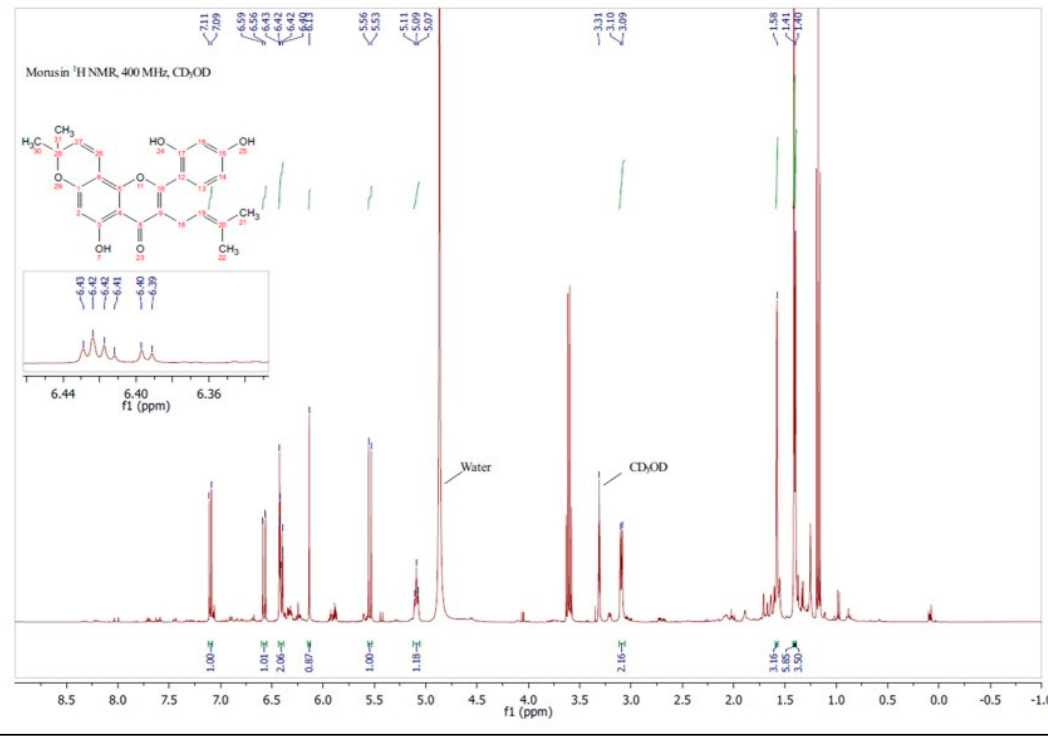
Figure A5. 1 H-NMR (400 MHz, CD 3 OD) spectrum of the compound Morusin.